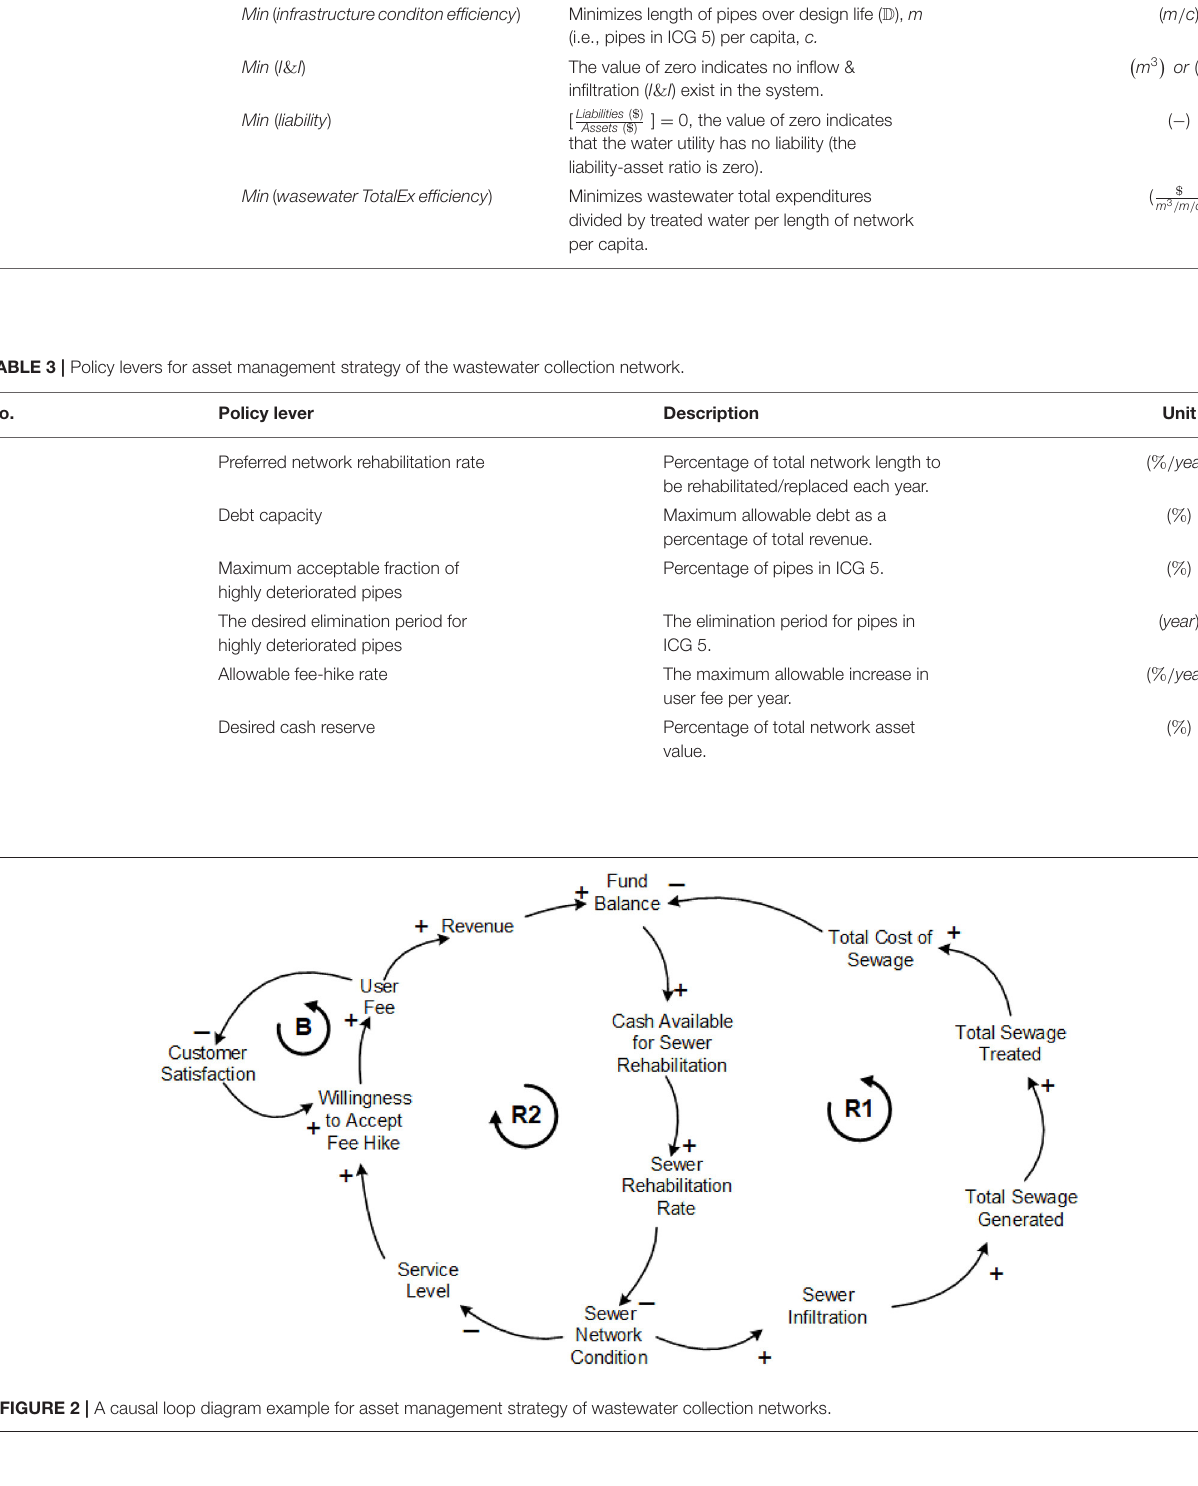
Frontiers in Water |